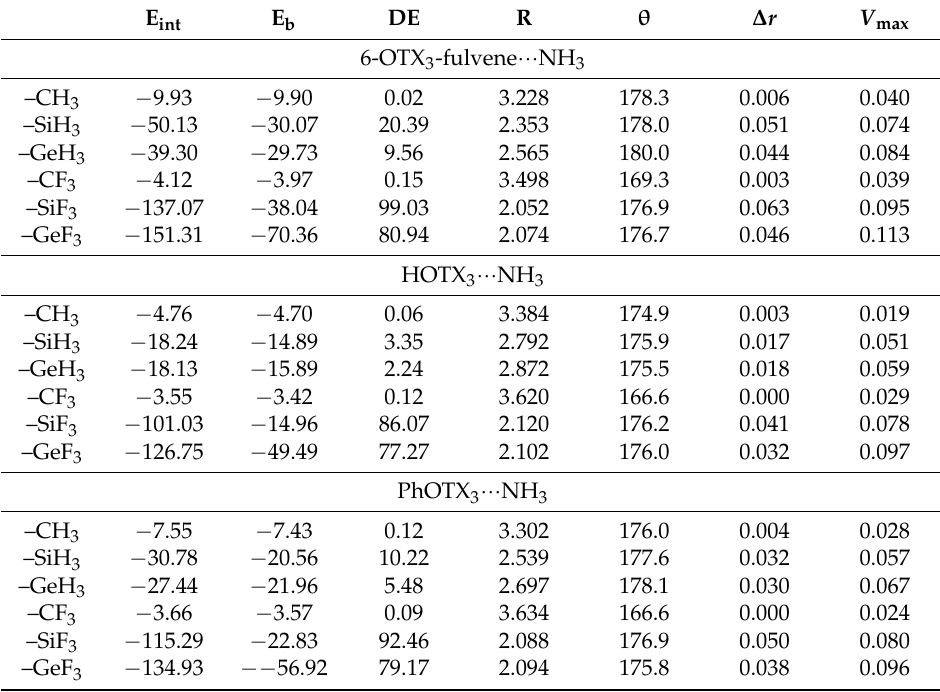
Table 1. Interaction energy (E int , kJ/mol), binding energy (E b , kJ/mol), deformation energy